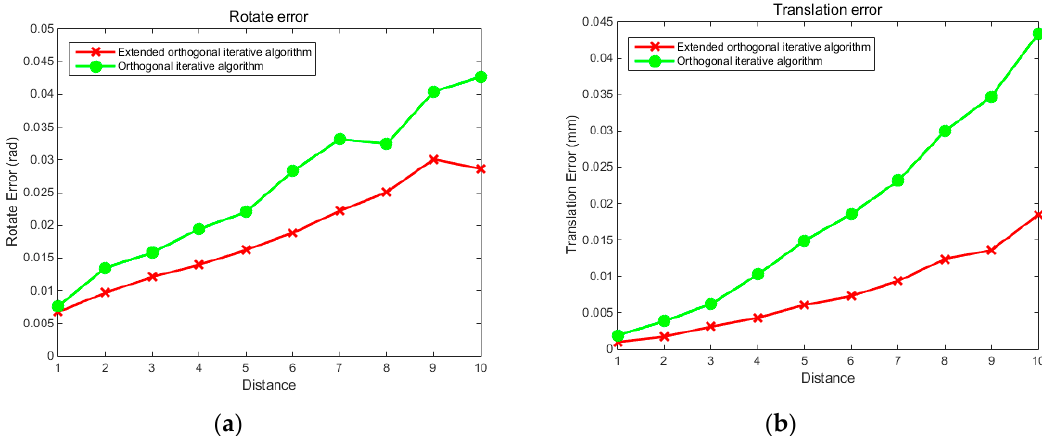
Figure 4. RMS error curve of rotation angle and translation affected by distance. Graph ( a ) shows the RMS error curve of the rotation angle at different distances, and graph ( b ) shows the RMS error curve of the translation at different distances.